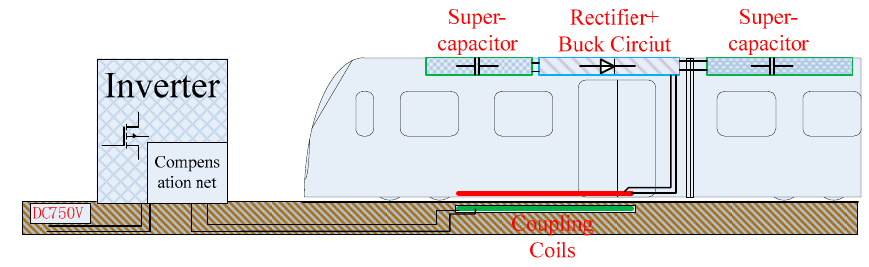
Figure 1. Wireless power transfer (WPT) system configuration in rail transit vehicles.